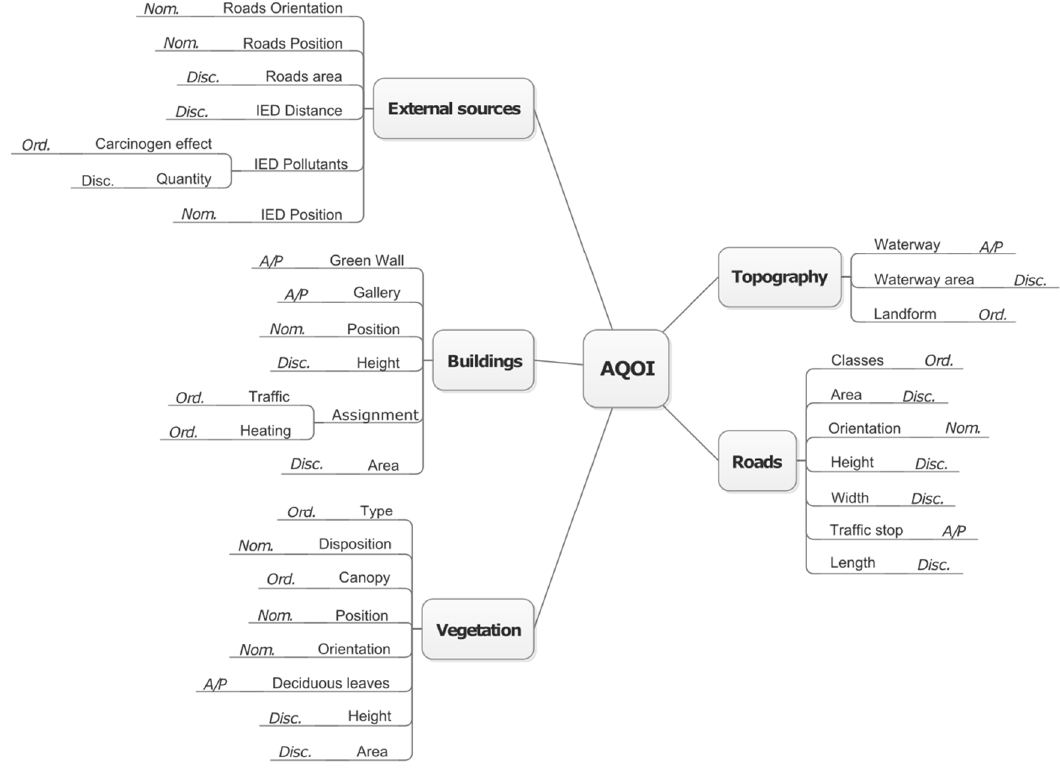
Figure 4. Parameters and their variables allowing for the calculation of the AQOI. The names of the variables and their type are presented (Disc. = discrete; A/P = absence/presence; Ord. = ordinal; Nom. = nominal).